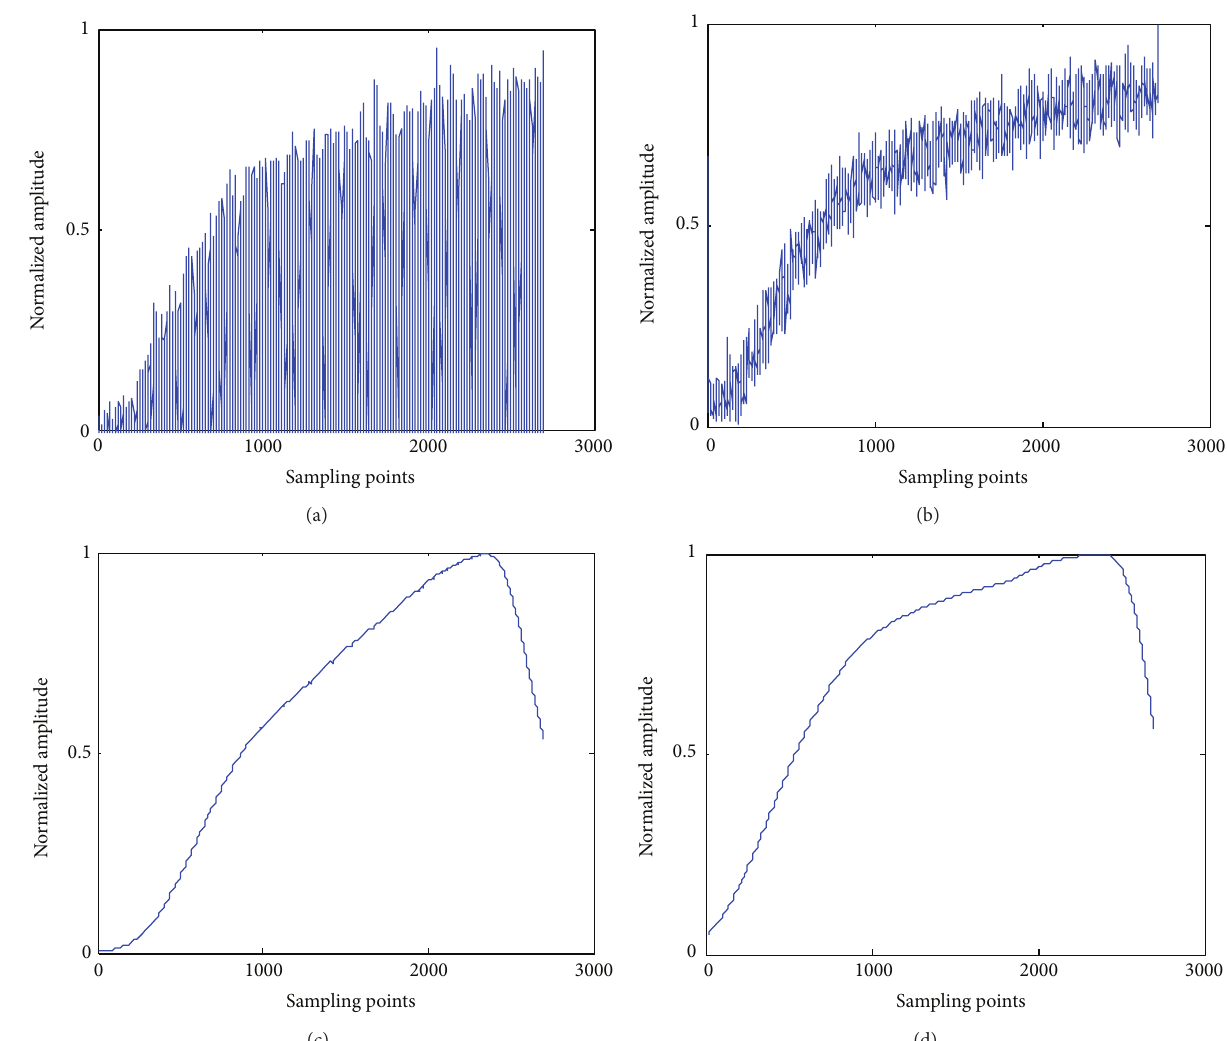
Figure 5: A comparison between Hilbert transform, spectrum slice analysis, and wavelet transform.